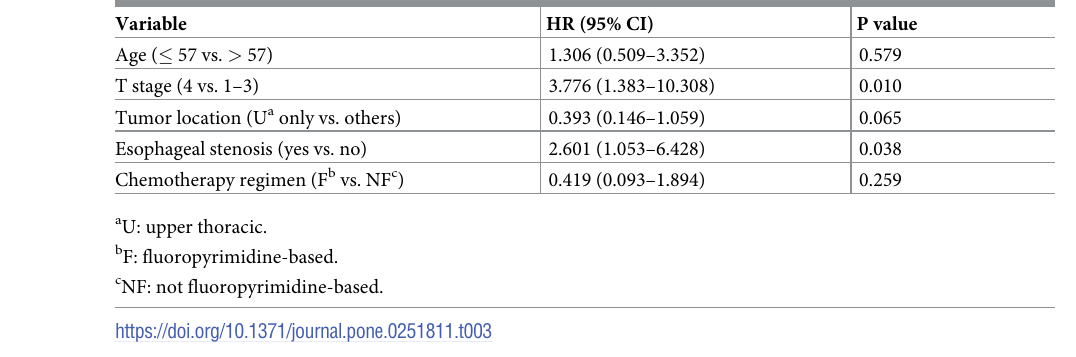
cancer team as the fistula location, perforation severity, cancer control status, medical condi- tion, and other patient personal factors were taken in account. In general, stent placement or surgical repair for the fistula was suggested if possible. In the present study, six patients under- went the airway or esophageal stenting by endoscope with or without fluoroscopy (S2 Table), and three patients received surgical repair for the fistula. On the other hand, the remaining 11 patients had antibiotics and conservative treatments due to the reasons which were listed in S3 Table. Eighteen patients with esophageal fistula died at data cutoff date. The causes of deaths included fistula-related massive hemorrhage in one, cancer progression in six, cancer progres- sion plus fistula-related infection in five, and fistula-related infection in six patients. Among the 20 patients with esophageal fistula, the median survival after the fistula was 3.1 months.